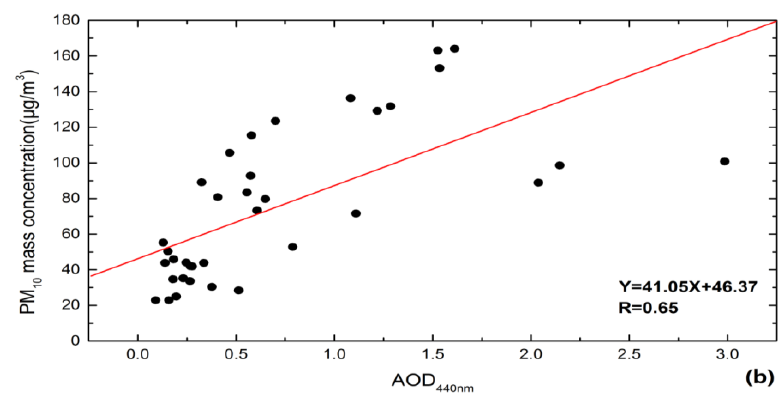
Figure 3. Linear fitting of PM 2.5 ( a ) and PM 10 ( b ) with AOD 440 .